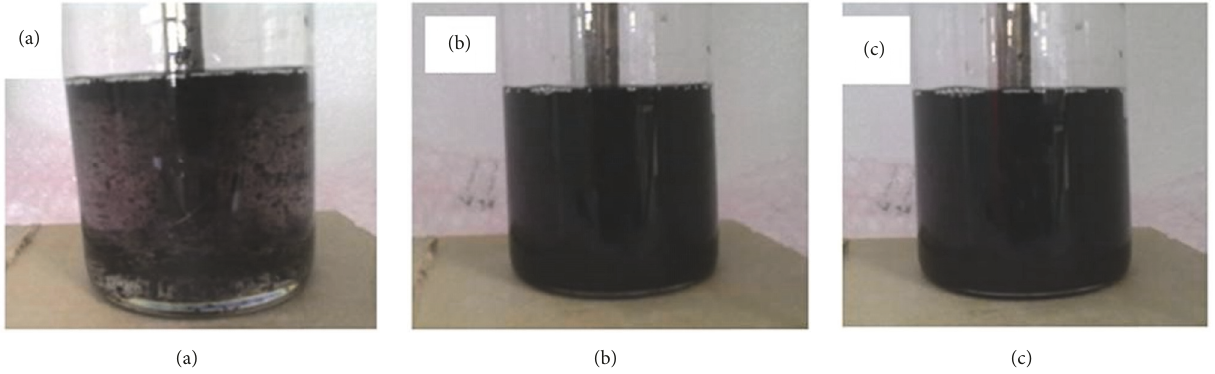
Figure 2: Status of Mix of MWCNT and epoxy resin after (a) 5 min; (b) 1 hour; (c) 2 hours of sonication.